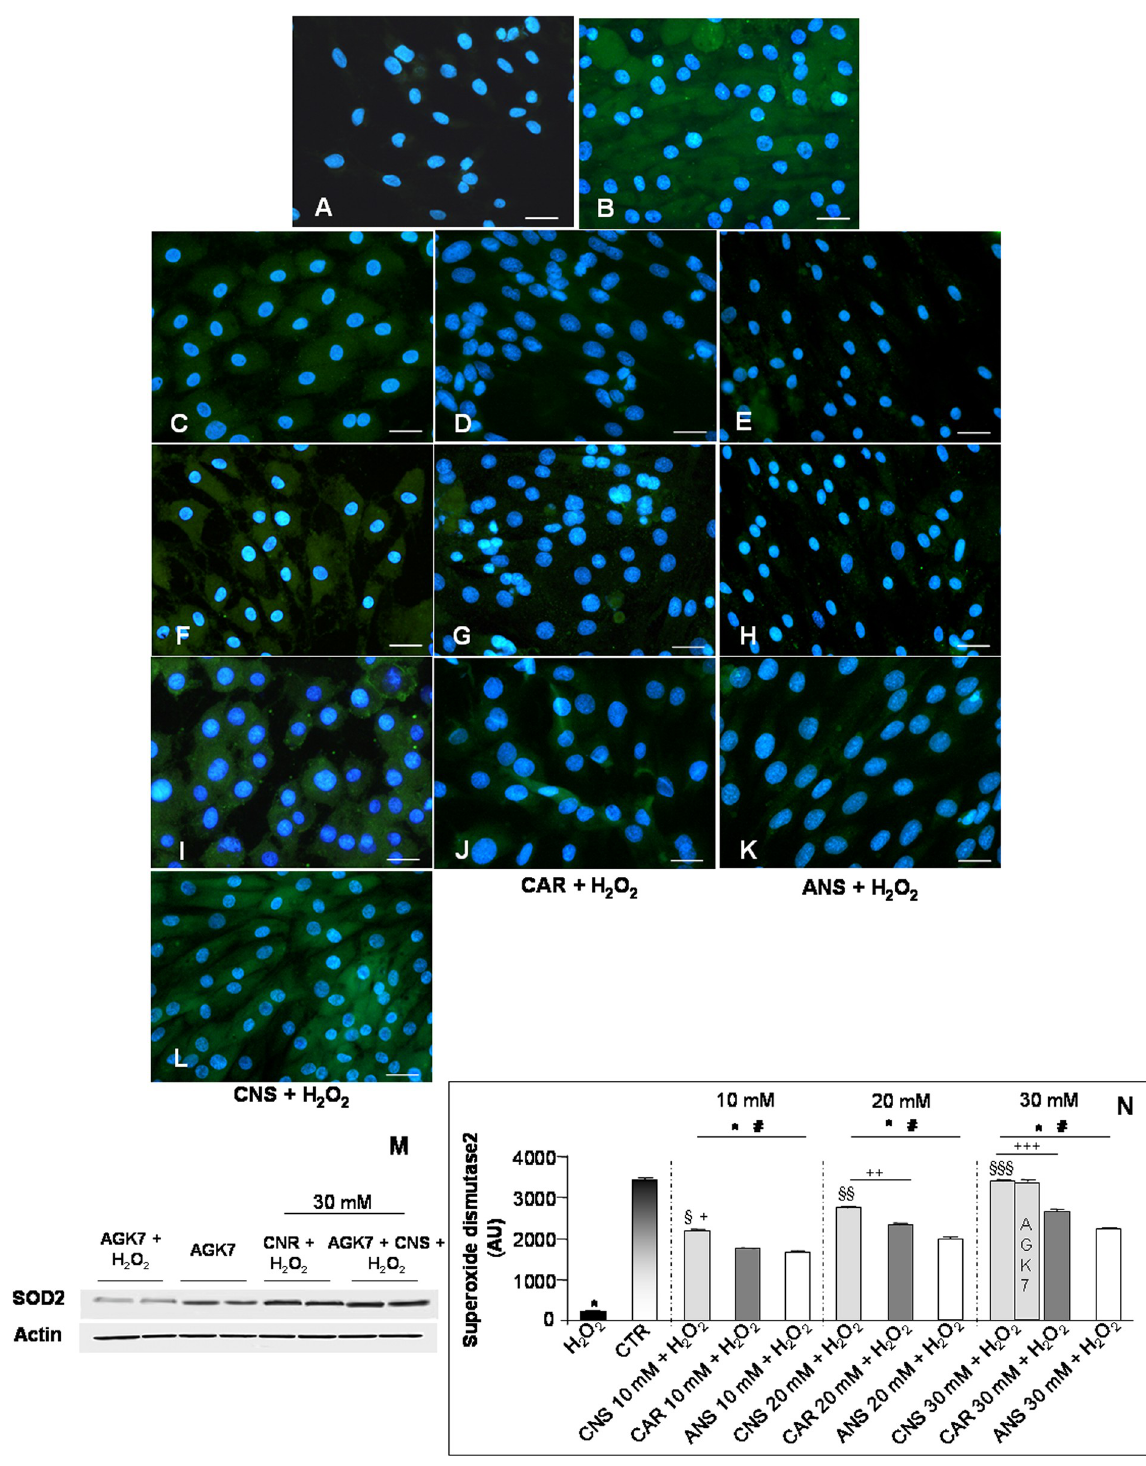
Fig 5. Superoxide dysmutase2 expression. Immunofluorescence photomicrographs of superoxide dysmutase2 (SOD2—green staining) of myotubes treated with hydrogen peroxide—H 2 O 2 (A), untreated control myotubes—CTR (B), myotubes pre-incubated with carnosinol followed by H 2 O 2 -treatment—CNS + H 2 O 2 (C, F, I), pre-incubated with carnosine followed by H 2 O 2 -treatment—CAR + H 2 O 2 (D, G, J) and pre-incubated with anserine followed by H 2 O 2 -treatment—ANS + H 2 O 2 (E, H, K) at the concentrations of 10 mM (C-E), 20 mM (F-H) and 30 mM (I-K) and myotubes incubated with AGK7 then with carnosinol (30 mM) and followed by H 2 O 2 -treatment—AGK7 + CNS + H 2 O 2 (L).